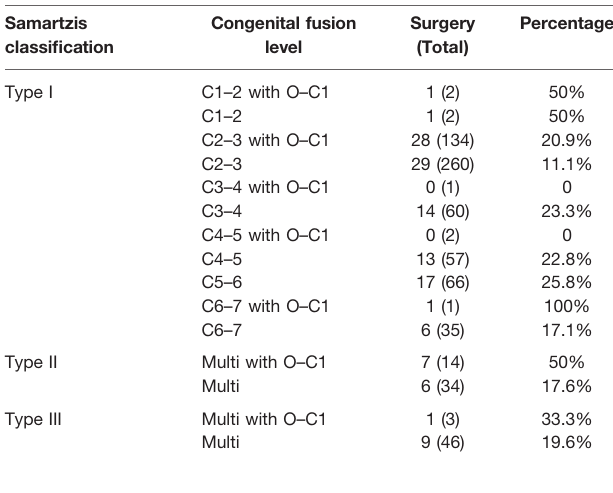
TABLE 3 | The distribution of surgical treatment in fusion levels.